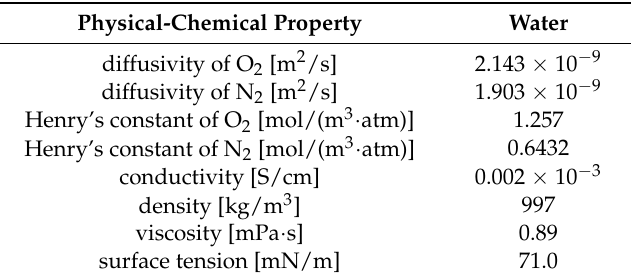
Table 2. Physical-chemical properties of the phases at 25 ◦